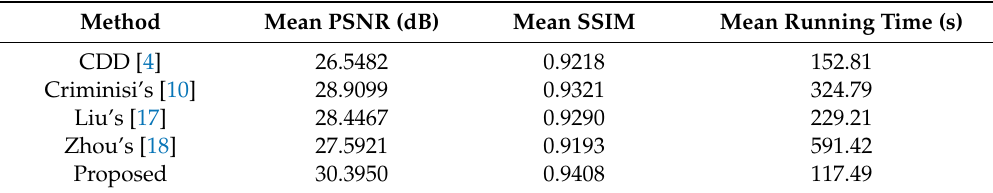
Table 4. Average values in Figures 12–14.